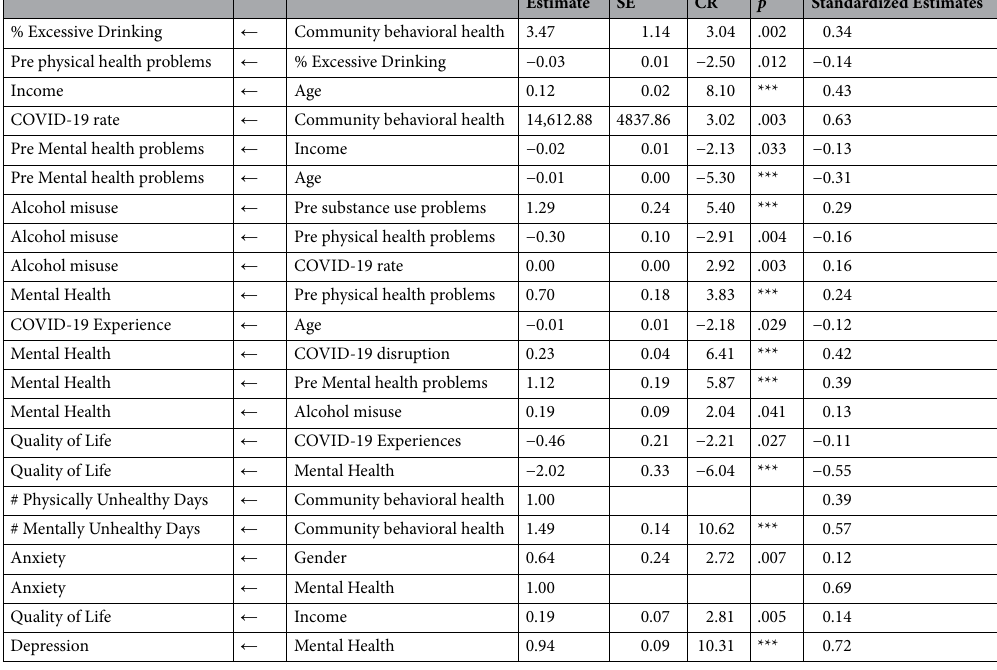
Table 3. Path Coefficients. *** p <